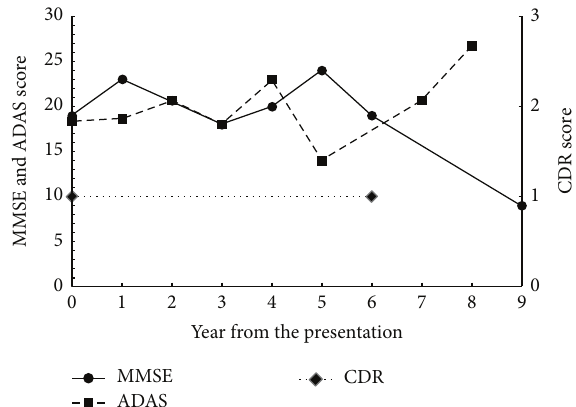
Figure 10: Changes in scores on the Mini Mental Scale Examination (MMSE), Alzheimer’s Disease Assessment Scale-cognitive subscale (ADAS), and Clinical Dementia Rating (CDR) of the patient in Case C. These scores remained stable for 6 years and gradually declined for the last 3